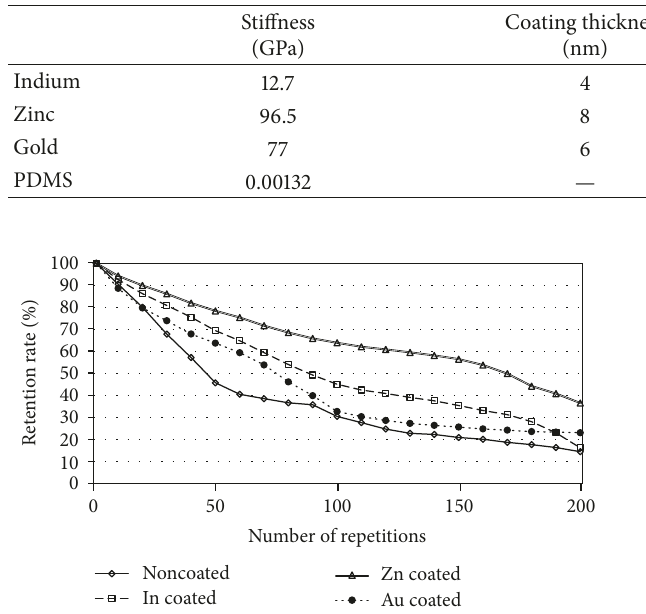
Figure 4: Changes in shear adhesion strength of synthetic dry adhesives (a) without coating and coated with (b) indium, (c) zinc, and (d) gold with respect to repetitions of frictional adhesion test. Table 3: Comparison of the bending stiffness of SDAs with and without metal coatings and the surface energy of the coating metals.